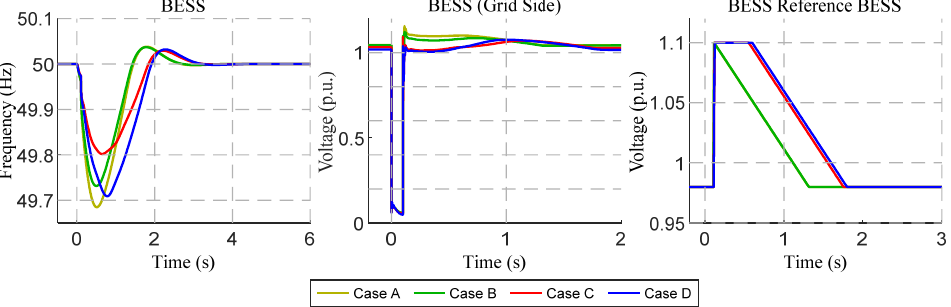
Figure 31. BESS power converter synthetic frequency and reference and terminal voltages: influence of different shares of